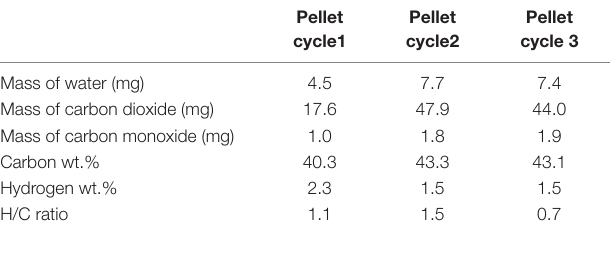
TaBle 4 | Mass of water, carbon monoxide, and carbon dioxide determined by the FT-ir and the h/c ratio for a sample of mass of approximately 20